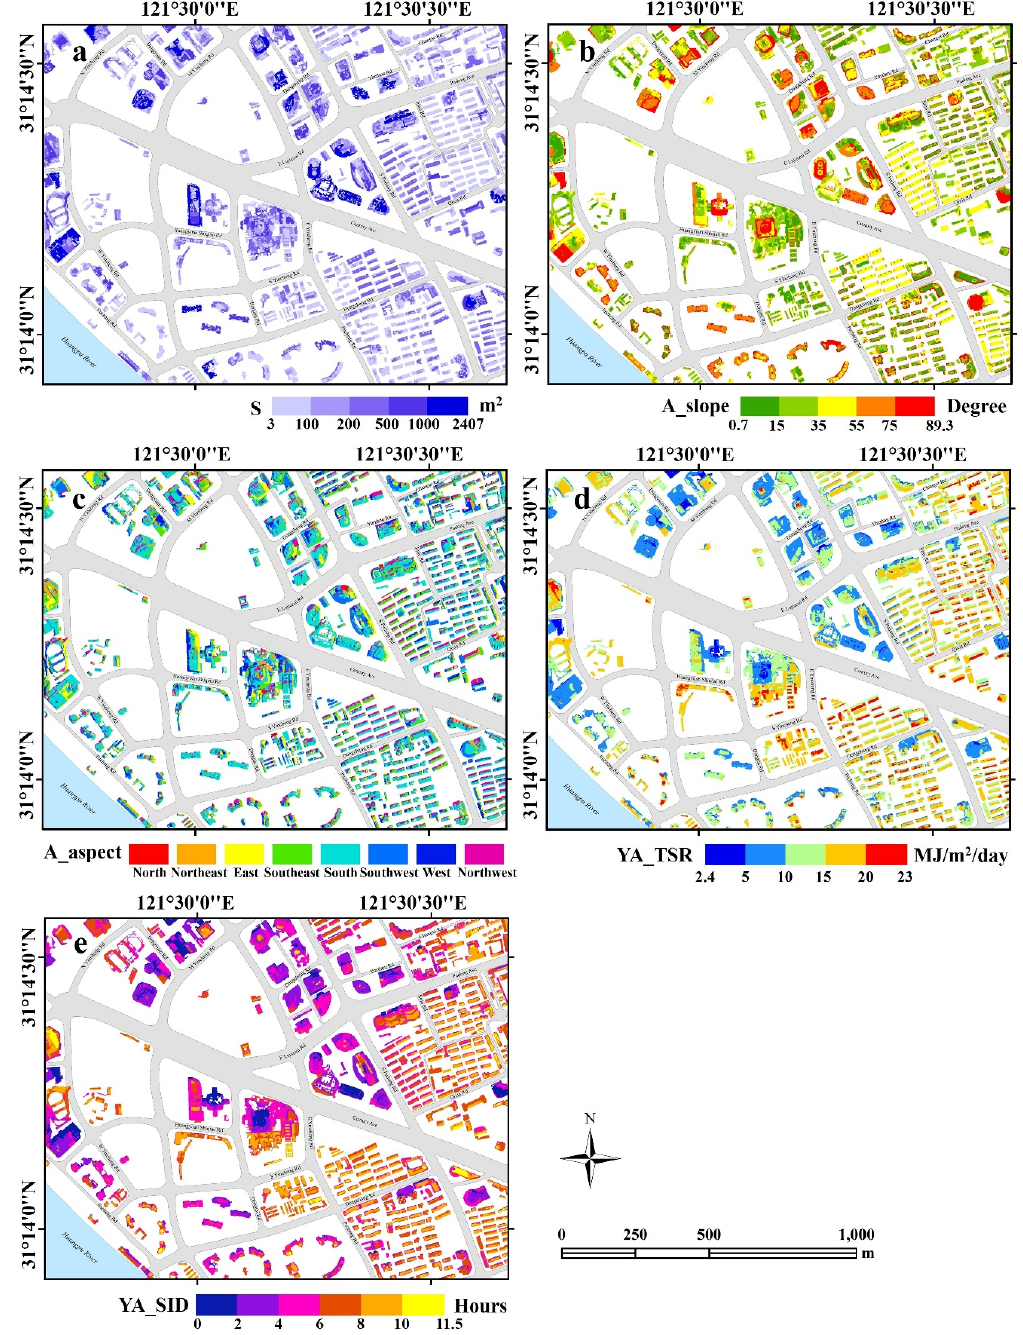
Figure 9. Five parameters of roof planes for identifying suitable places for rooftop solar panel installation in the Lujiazui region. ( a ) Area (S); ( b ) Average slope (A_slope); ( c ) Average aspect (A_aspect); ( d ) Yearly average total solar radiation (YA_TSR); and ( e ) Yearly average solar illumination duration (YA_SID).